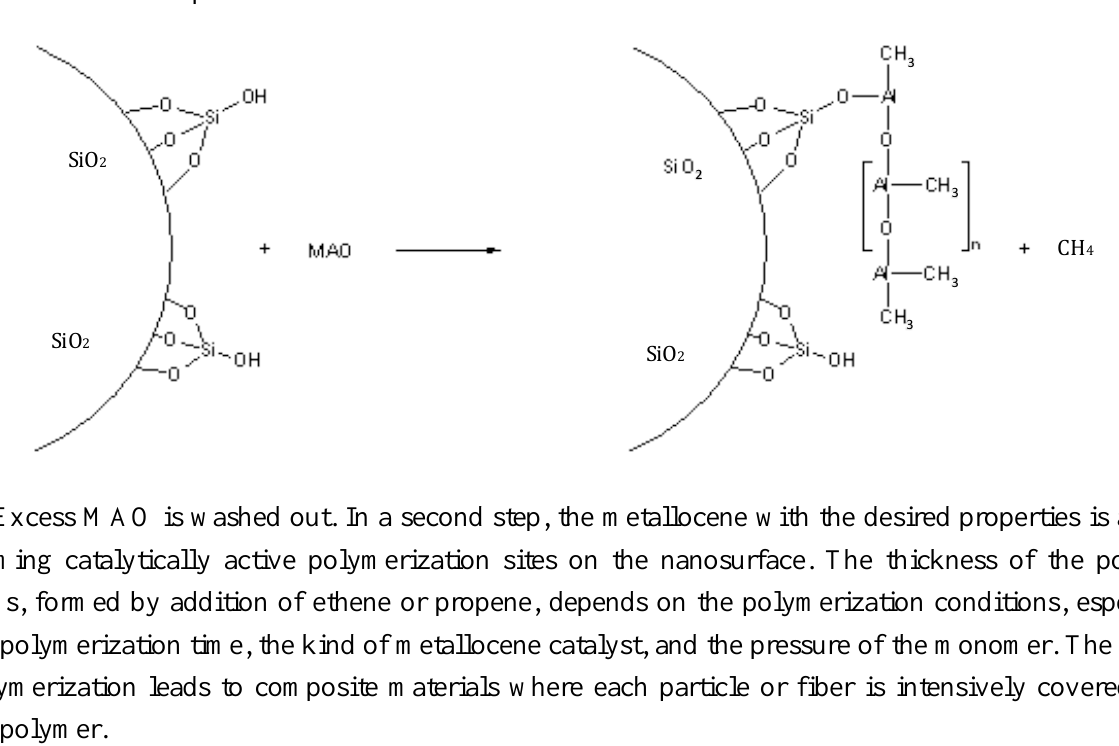
Figure 2. Hydroxyl or carboxyl groups present on the filler surface can react with added MAO to form a heterogeneous cocatalyst. The MAO is now anchored, but still able to form an active complex with the